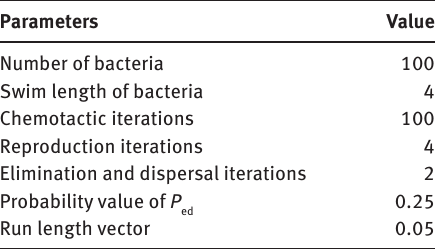
Table 2: BFA Parameters.